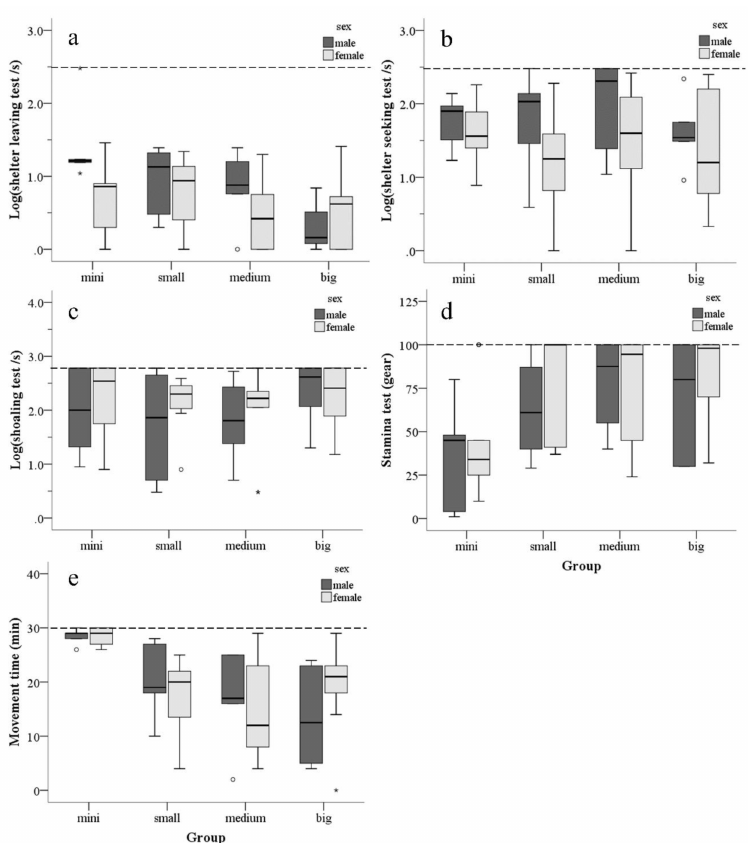
Figure 2. Test results for each group of males and females in each test. Abscissa: the size of di ff erent tank. Ordinate: ( a ) shelter leaving test time take logarithmic transformation (log 10 ); ( b ) shelter seeking test time take logarithmic transformation (log 10 ); ( c ) shoaling test time take logarithmic transformation (log 10 ); ( d ) maximum gear for stamina test; and ( e ) activity pattern in half an hour. Dotted line: